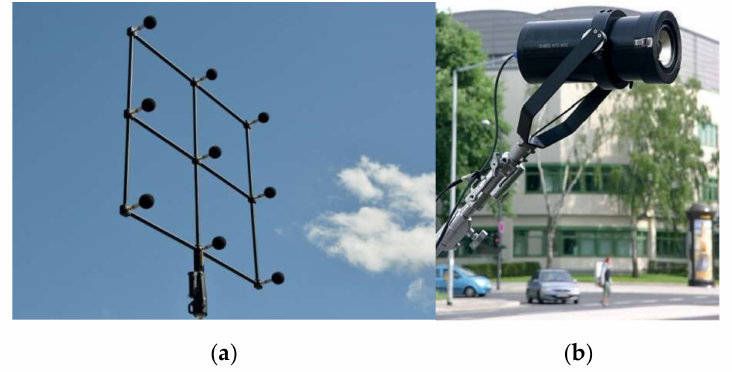
Figure 3. ( a ) Grid of 9 microphones; ( b ) noise source characteristics of given traffic